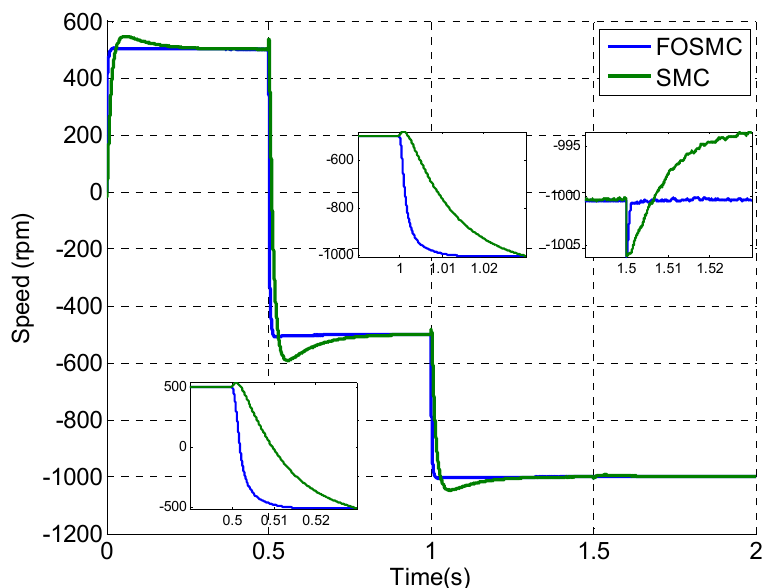
Figure 11. Comparison of speed response of FOSMC and SMC speed controller when positive and negative reference speeds are given.